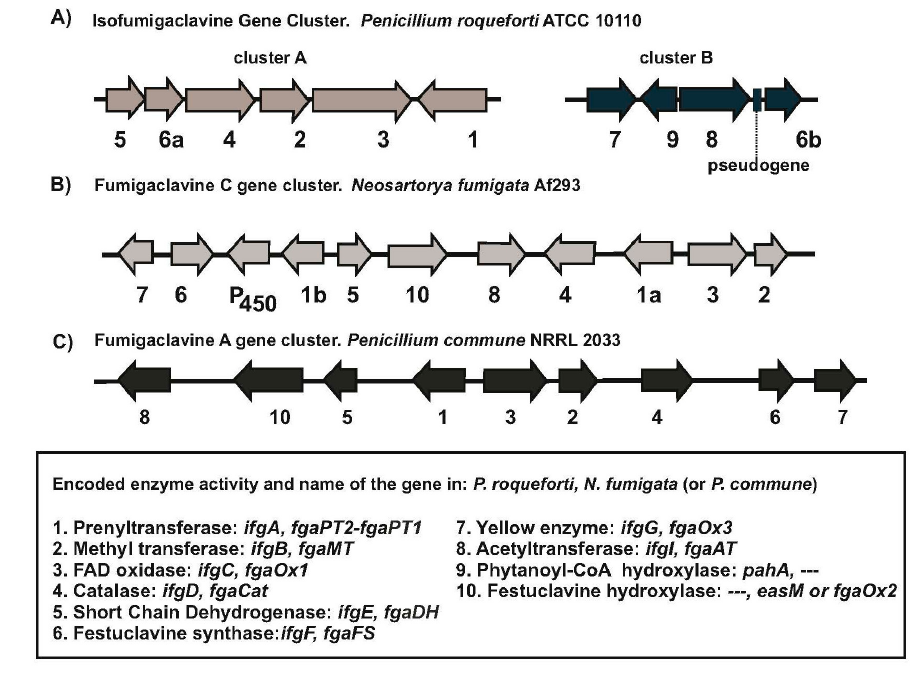
Figure 2. Organization of the clavine gene clusters. ( A ) Clusters A and B of Isofumigaclavine in P. roqueforti ; ( B ) Fumigaclavine C gene cluster of N. fumigata . ( C ) Fumigaclavine A gene cluster of P. commune . In the lower panel the numbers correspond to the enzymatic activities encoded by the genes, followed by the gene names in P. roqueforti and N. fumigata / P. commune . The symbol “—” indicates that the corresponding gene is not present in the published cluster.